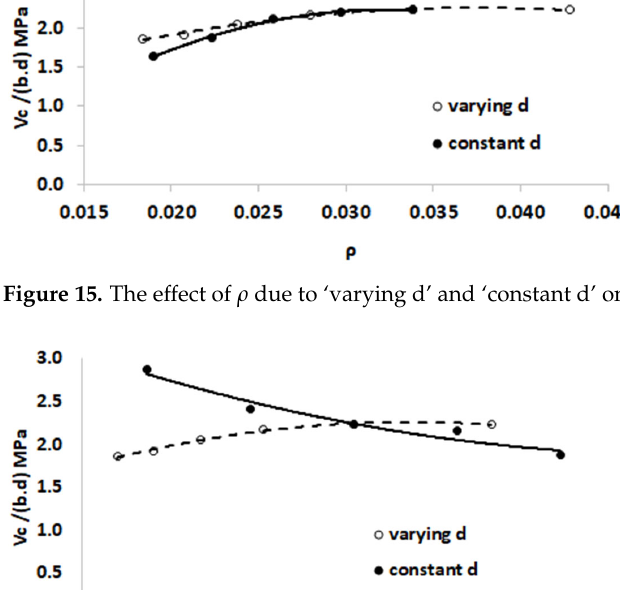
15 of 21 Figure 14. The effect of effective depth d of the beam on concrete shear strength. Paying closer attention to Figure 14, it must be realized that the effect of d on the shear strength shown in the figure is obtained by numerical simulations with the following conditions: only the value of d is varied while other parameters, such as beam width b , reinforcement area ( As ), and shear span a , are kept constant. This means that the change in effective depth also generates changes in the size of the cross section (b.d), the